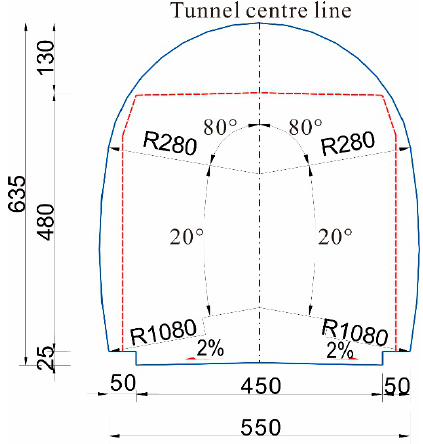
Figure 4. Sectional size drawing of the tunnel.